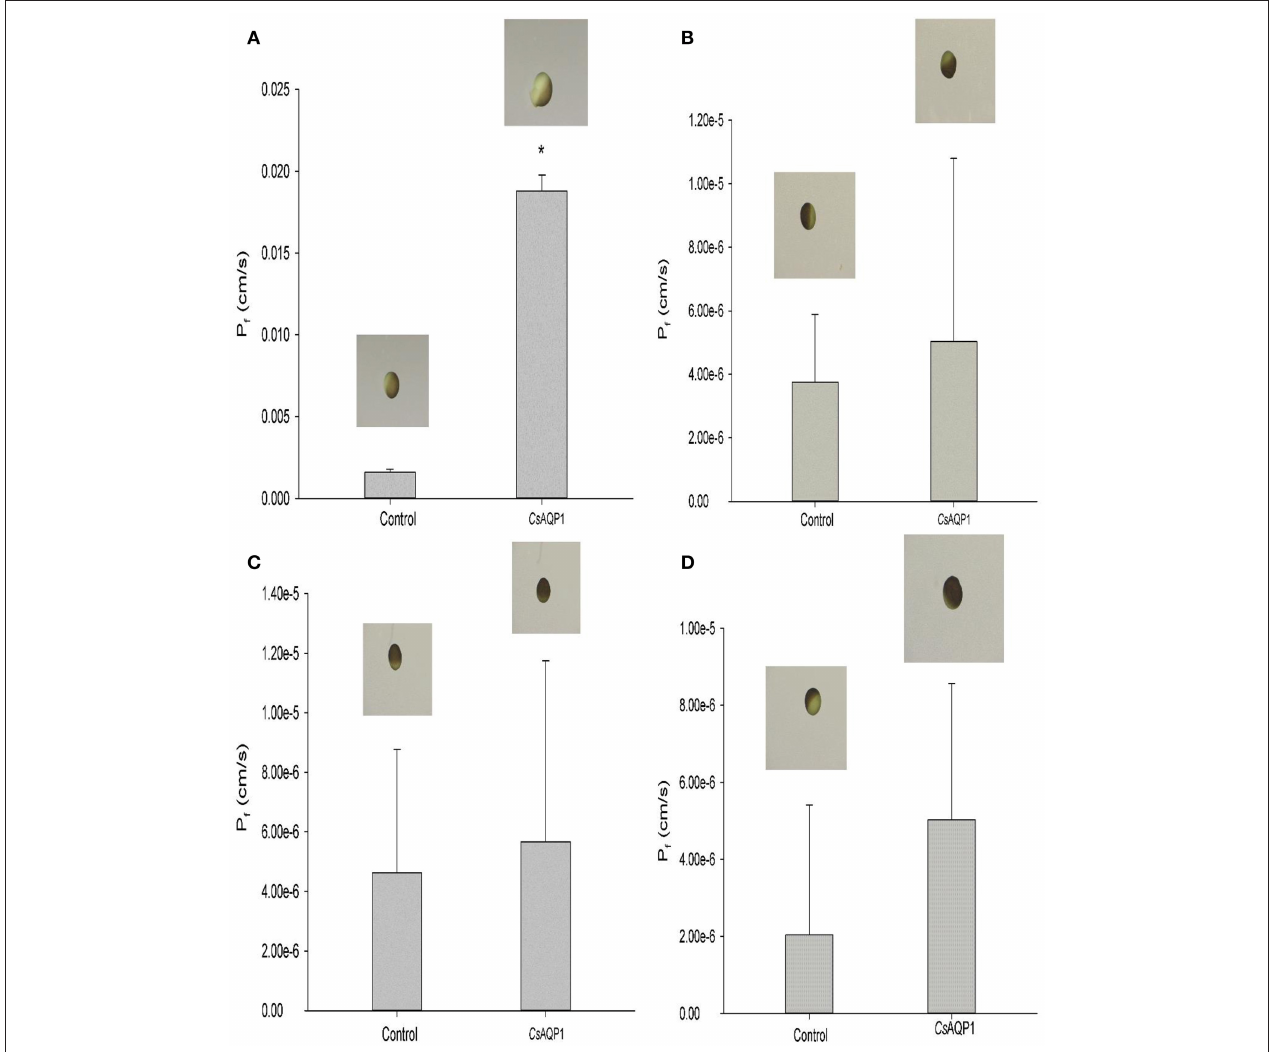
FIGURE 3 | Functional assay of Chilo suppressalis aquaporin ( Cs Drip1). (A) Water permeability of Cs Drip1. (B) Glycerol permeability of Cs Drip1. (C) Trehalose permeability of Cs Drip1. (D) Urea permeability of Cs Drip1. The graphs of oocytes assayed in the experiments were indicated above each bar. Error bars represented SEM ( n ≥ 9). Student’s t -test was performed to find means that were significantly ( p < 0.05) different from the water-injected control oocytes (indicated with asterisk).